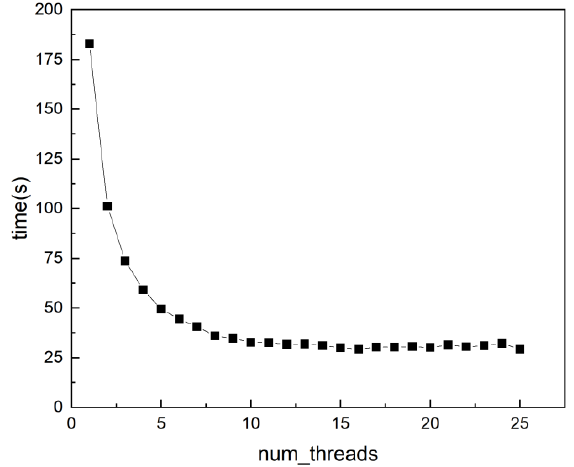
Figure 11. Different number of threads and their corresponding elapsed time.